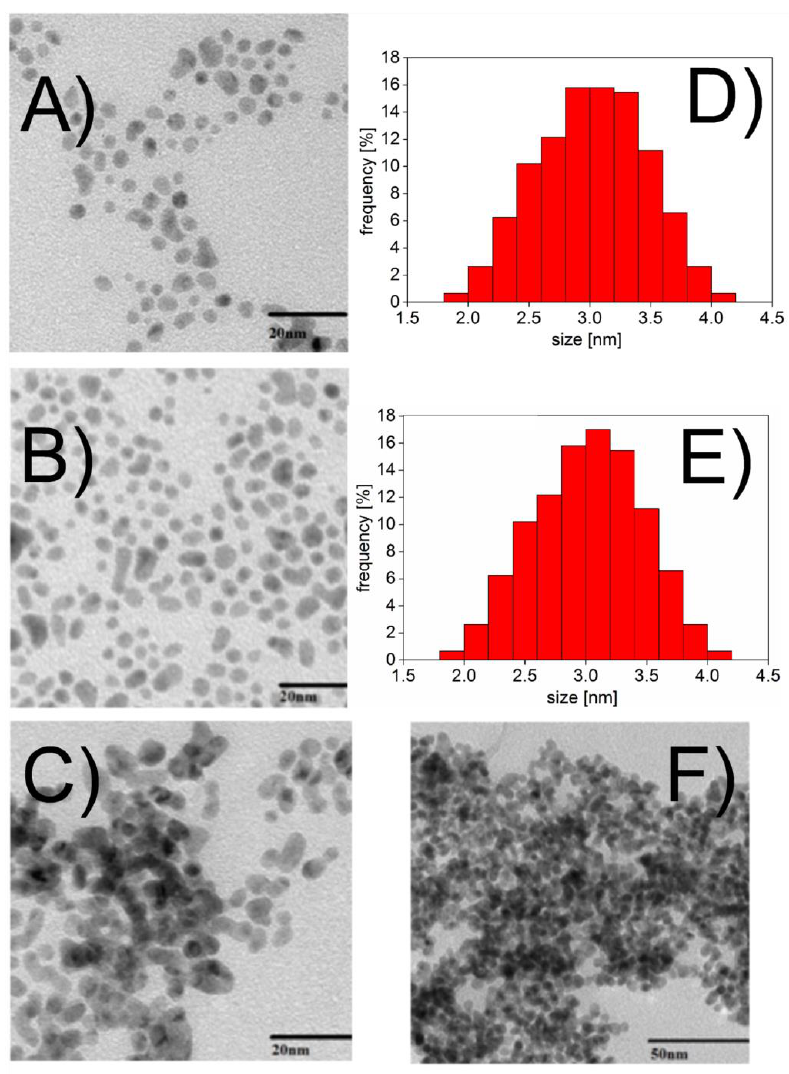
Figure 1. The TEM images of the PdNPs stabilized by 4-methylpyridine (PdNPs/4MePy): raw nanoparticles (NPs) ( A ), centrifuged and suspended ( B ), dried and re-suspended ( C and F : both images present the same NPs but with different magnification). Histograms (evaluated from more than 300 NPs) of size distribution for raw ( D ), and centrifuged ( E ) PdNPs/4MePy. Due to the formation of agglomerates, the histogram was not obtained for ”dried” PdNPs. See the Experimental Section for the synthesis conditions. TEM images and particle size distribution determined for PdNPs stabilized by N,N-dimethylaminopyridine and 4-ethylpyridine are provided in Figure S1-S4 in Supplementary Material.